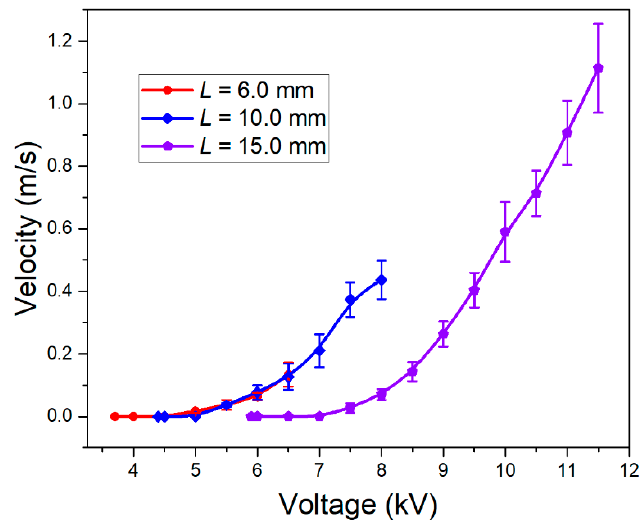
Figure 5. Average velocity of ionic wind with regard to operation voltage under three di ff erent needle-ring distances.